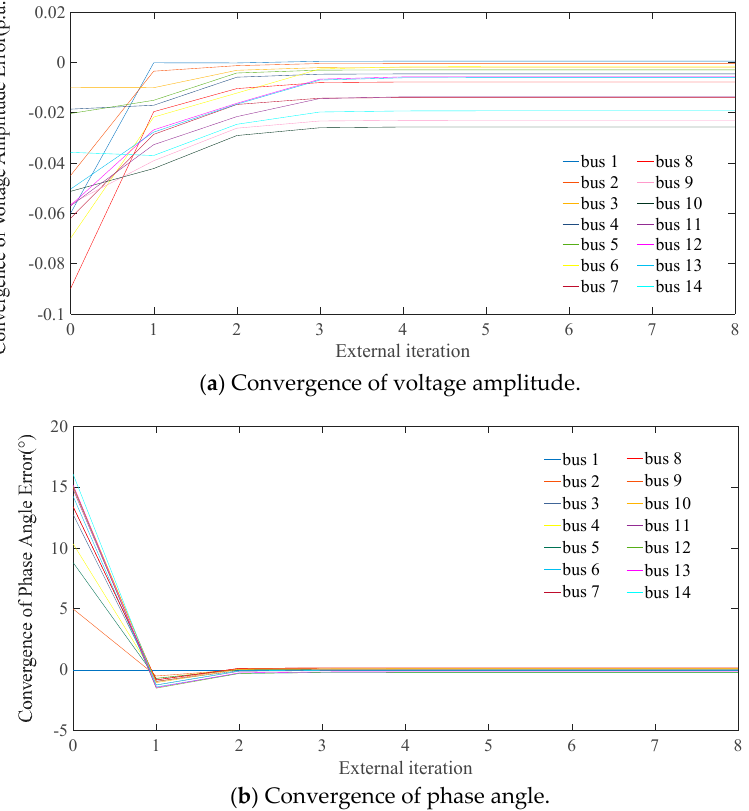
Figure 5. Convergence performance of proposed distributed method benchmarked with conventional centralized state estimation method for the IEEE 14-bus